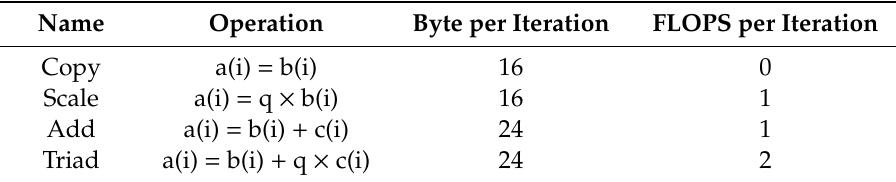
Table 4. STREAM benchmark computational kernels.